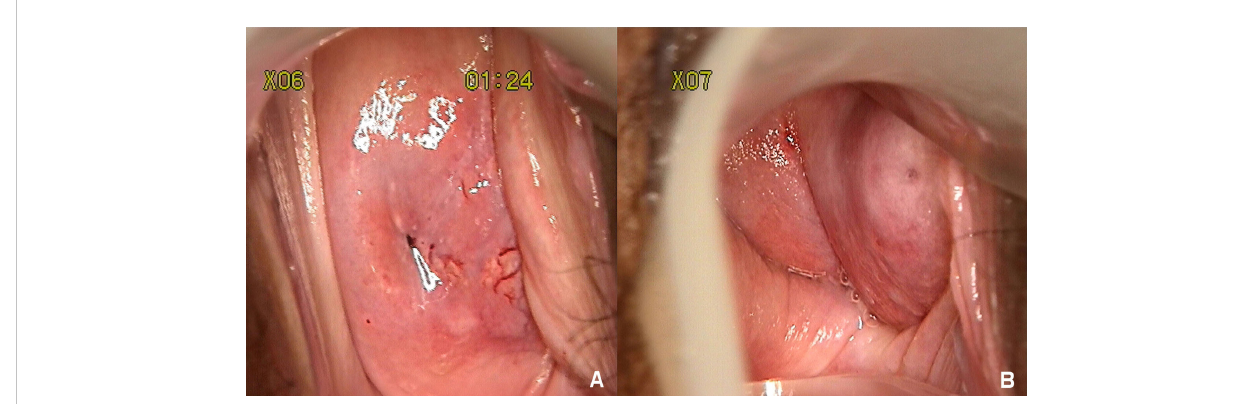
FIGURE 1 (A) Stained with acetic acid, thick vinegar white epithelium, and the accompanying abnormal blood vessels can be seen between 3 and 6 o'clock of the right cervix. (B) The nondominant left cervix was concealed by the side wall of the left vagina. After exposing, the left side cervix presented a mature appearance which was smaller than a normal